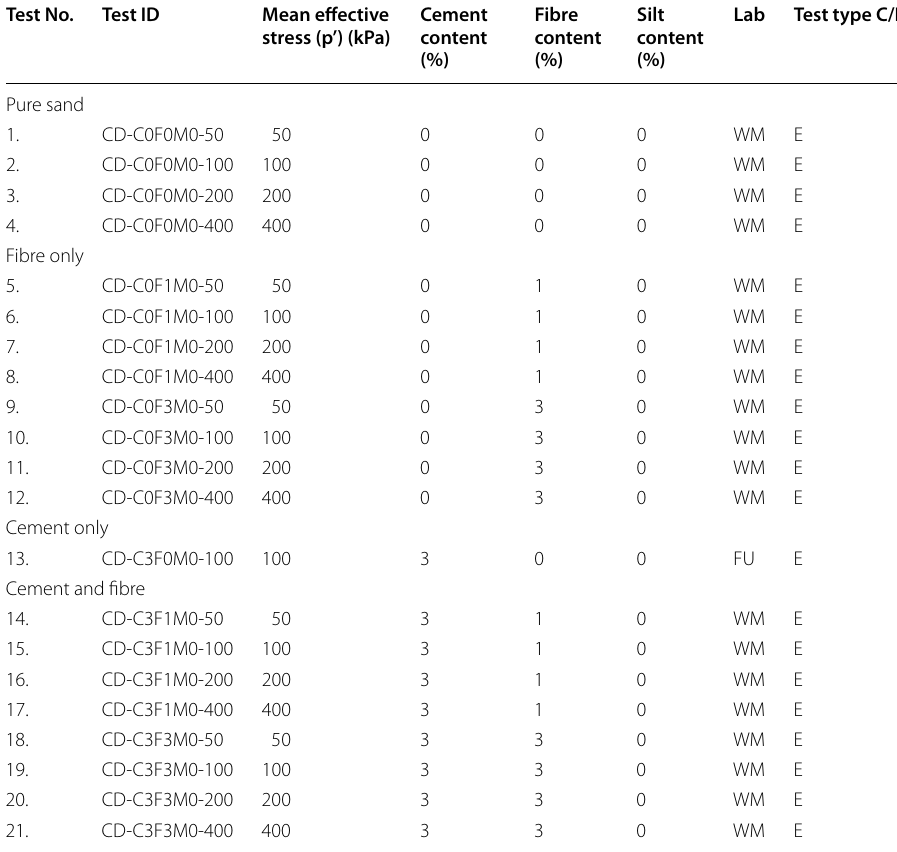
Table. 2 Testing program for consolidated drained (CID) extension tests (Current Study) Test